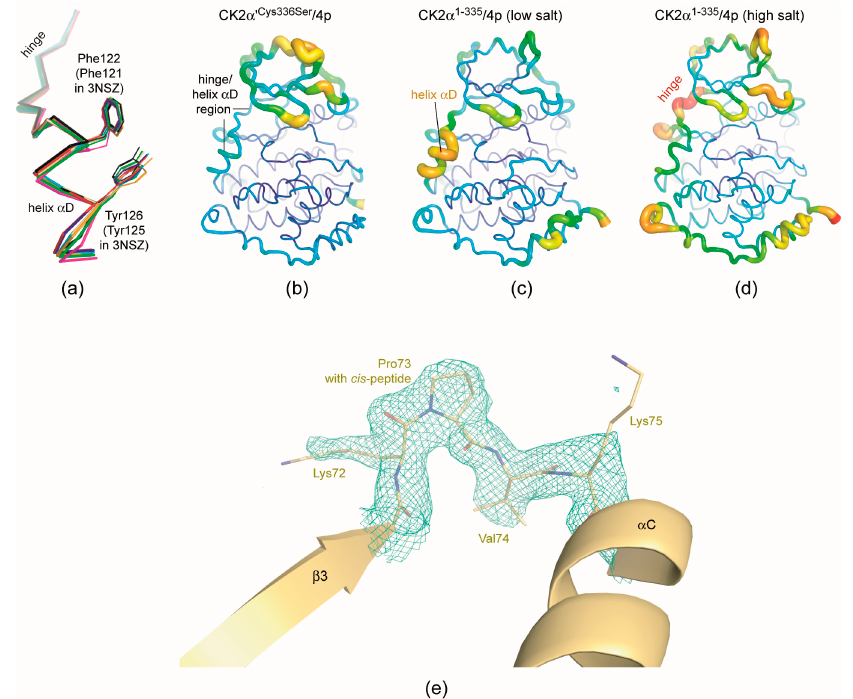
Figure 6. Structural features of the CK2 α′ Cys336Ser / 4p complex. ( a ) Overlay of the hinge/helix α D regions of the two CK2 α′ protomers of this study (red and blue), of CK2 α 2 − 331 in 3NSZ [44] as a reference structure for the open hinge/helix α D conformation (black) and of all other CK2 α′ chains available in the PDB (3OFM [31]: green; 3E3B [39]: magenta; 5M4U [38]: orange; 5M56-chain A: cyan; 5M56-chain B [38]: yellow); due to an insertion of one residue in the N-terminal segment of CK2 α′ the numbering schemes of CK2 α and CK2 α′ are not identical: Phe121 and Tyr125 of CK2 α are equivalent to Phe122 and Tyr126 of CK2 α′ . ( b – d ) Rainbow representation of the atomic B-factors in the CK2 α′ Cys336Ser / 4p complex ( b ) and for comparison in the low-salt the CK2 α 1 − 335 / 4p complex ( c ) and in the low-salt the CK2 α 1 − 335 / 4p complex ( d ). Large B-factors (and thus high internal mobilities): red and thick; low B-factors (and thus low internal mobilities): blue and thin. ( e ) A cis-peptide bond between Lys72 and Pro73 in chain A of the CK2 α′ Cys336Ser / 4p complex structure testified by the final electron density (cutoff level 1.0 σ ).